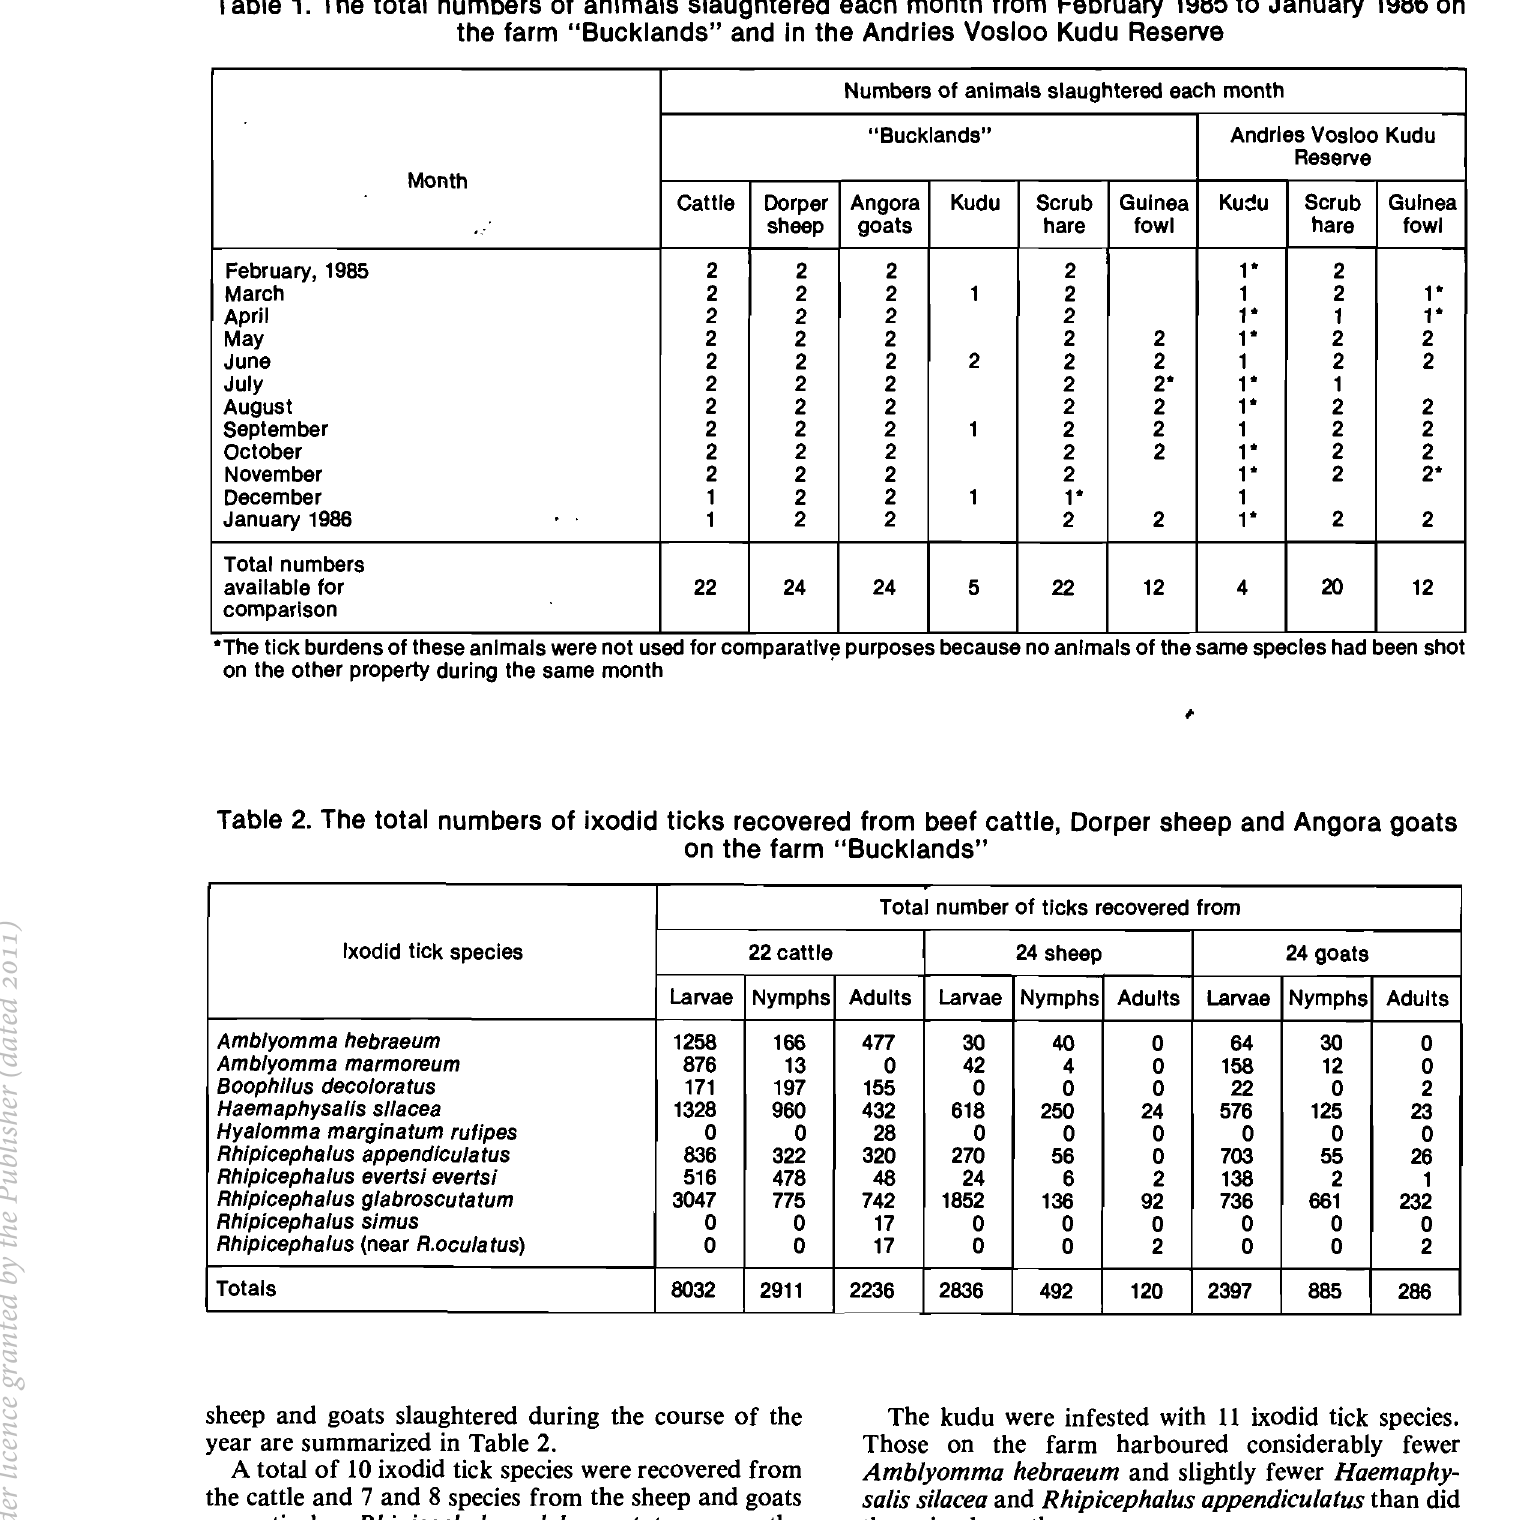
Table 1. The total numbers of animals slaughtered each month from February 1985 to January 1986 on the farm "Bucklands" and in the Andries Vosloo Kudu Reserve Numbers of animals slaughtered each month "Bucklands" Andries Vosloo Kudu Reserve Month Cattle Dorper Angora